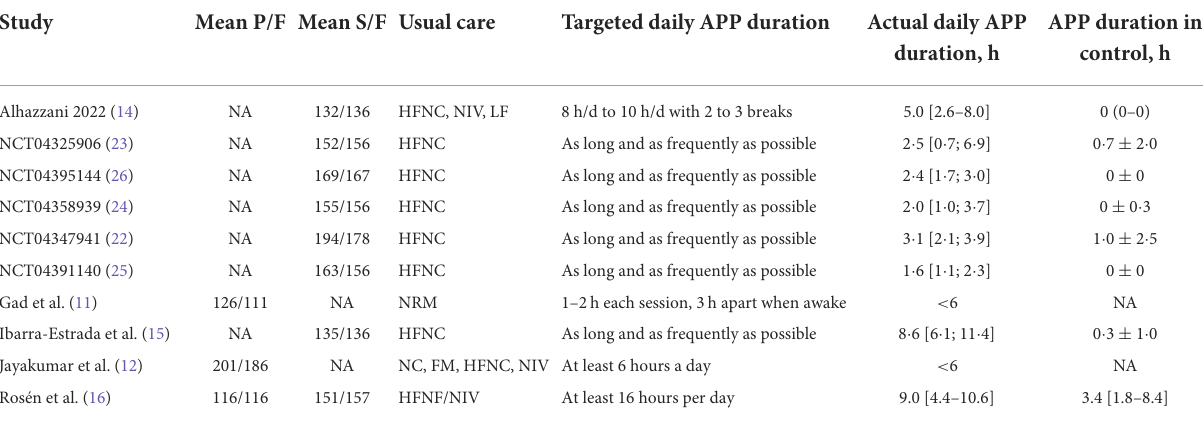
TABLE 2 Respiratory characteristics and treatment regimens in the included